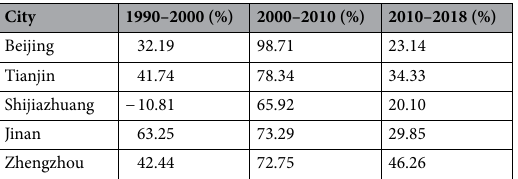
Table 3. Growth rate of ILU degree, with the trend in line with the S-curve.